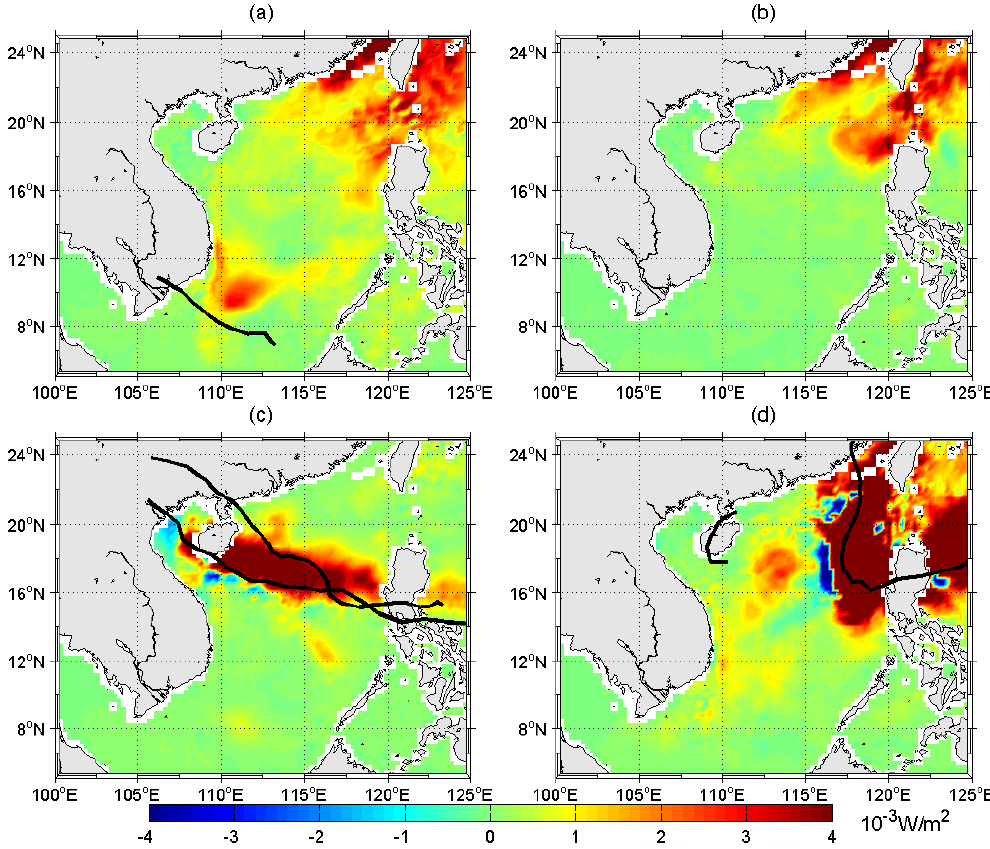
Figure 8. Spatial distribution of the monthly mean near-inertial energy input by wind in (a) January, (b) April, (c) July, and (d) October in 2010. The black line is the best track of TC derived from the Joint Typhoon Warning Center